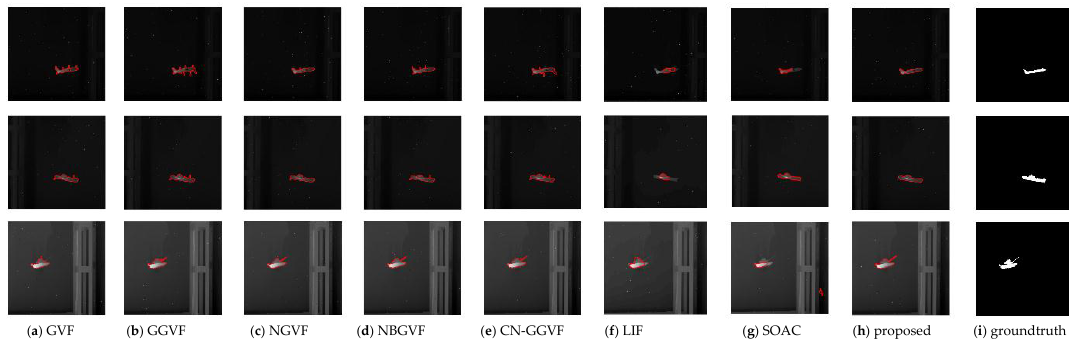
Sensors 2016 , 16 , 1756